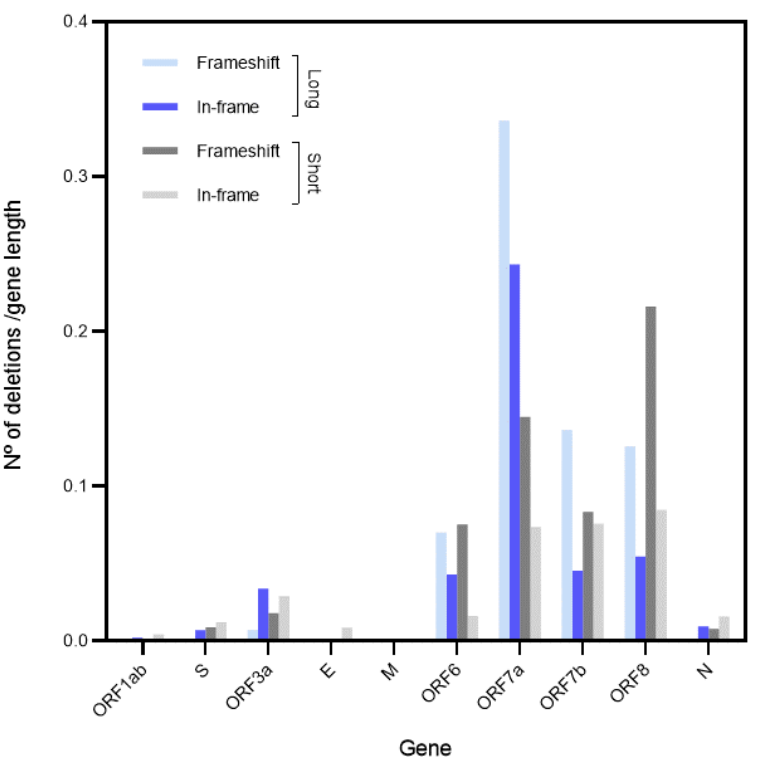
Figure 5. Distribution of deletions across SARS-CoV-2 genes; the Y-axis represents the number of deletions divided by the gene length (the density of deletions).